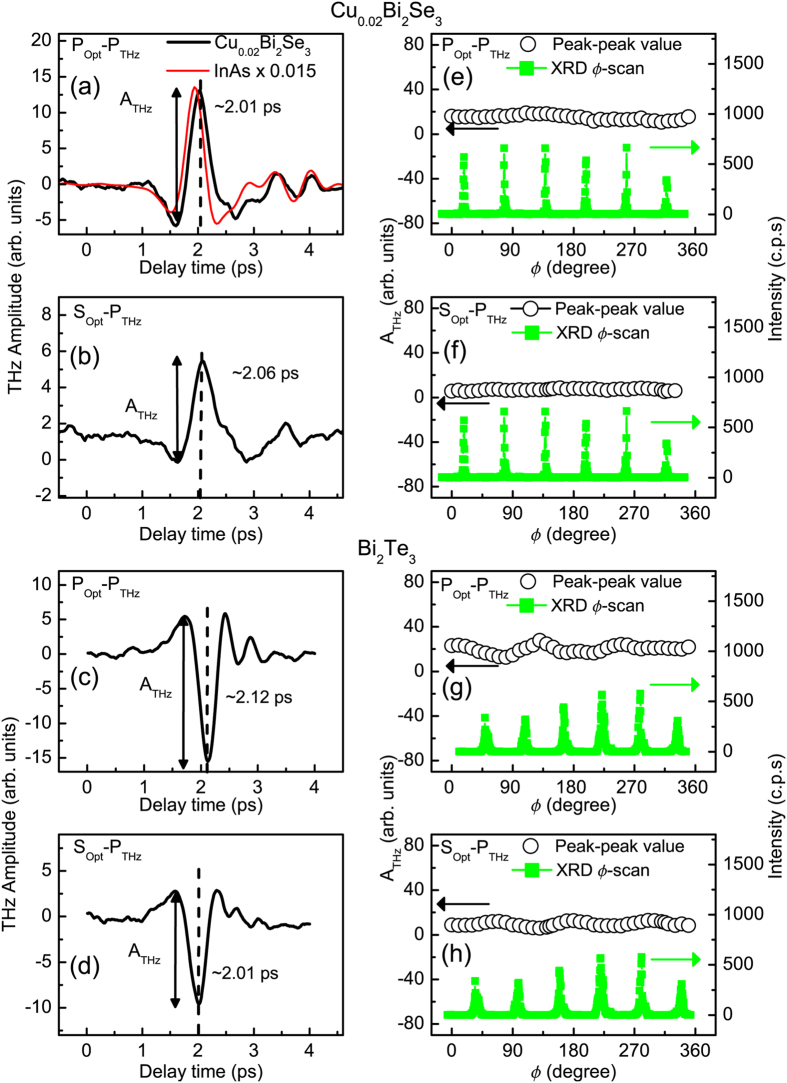
(a–d) Time-domain P-polarized THz waveforms radiated from the (111) surface of n-type Cu0.02Bi2Se3 and p-type Bi2Te3 by P- and S-polarized optical pulse excitation. In (a), the thin-red line represents the 0.015-times smaller P-polarized THz wave that is generated from an n-type InAs under the same conditions. In both POpt-PTHz and SOpt-PTHz configurations, the polarities of the P-polarized THz waveforms from p-type Bi2Te3 (c,d) are in the reverse of that from n-type Cu0.02Bi2Se3 (a,b). ATHz is the peak-to-peak value of the THz waveform. (e–h): the plots of ATHz for the P-polarized THz waveforms as a function of azimuthal angles (-scan) of Cu0.02Bi2Se3 (a,b) and Bi2Te3 (c,d) single crystals (black). The corresponding XRD -scans for the (1 1 15) peak for both single crystals are also shown in (e–h) (green).